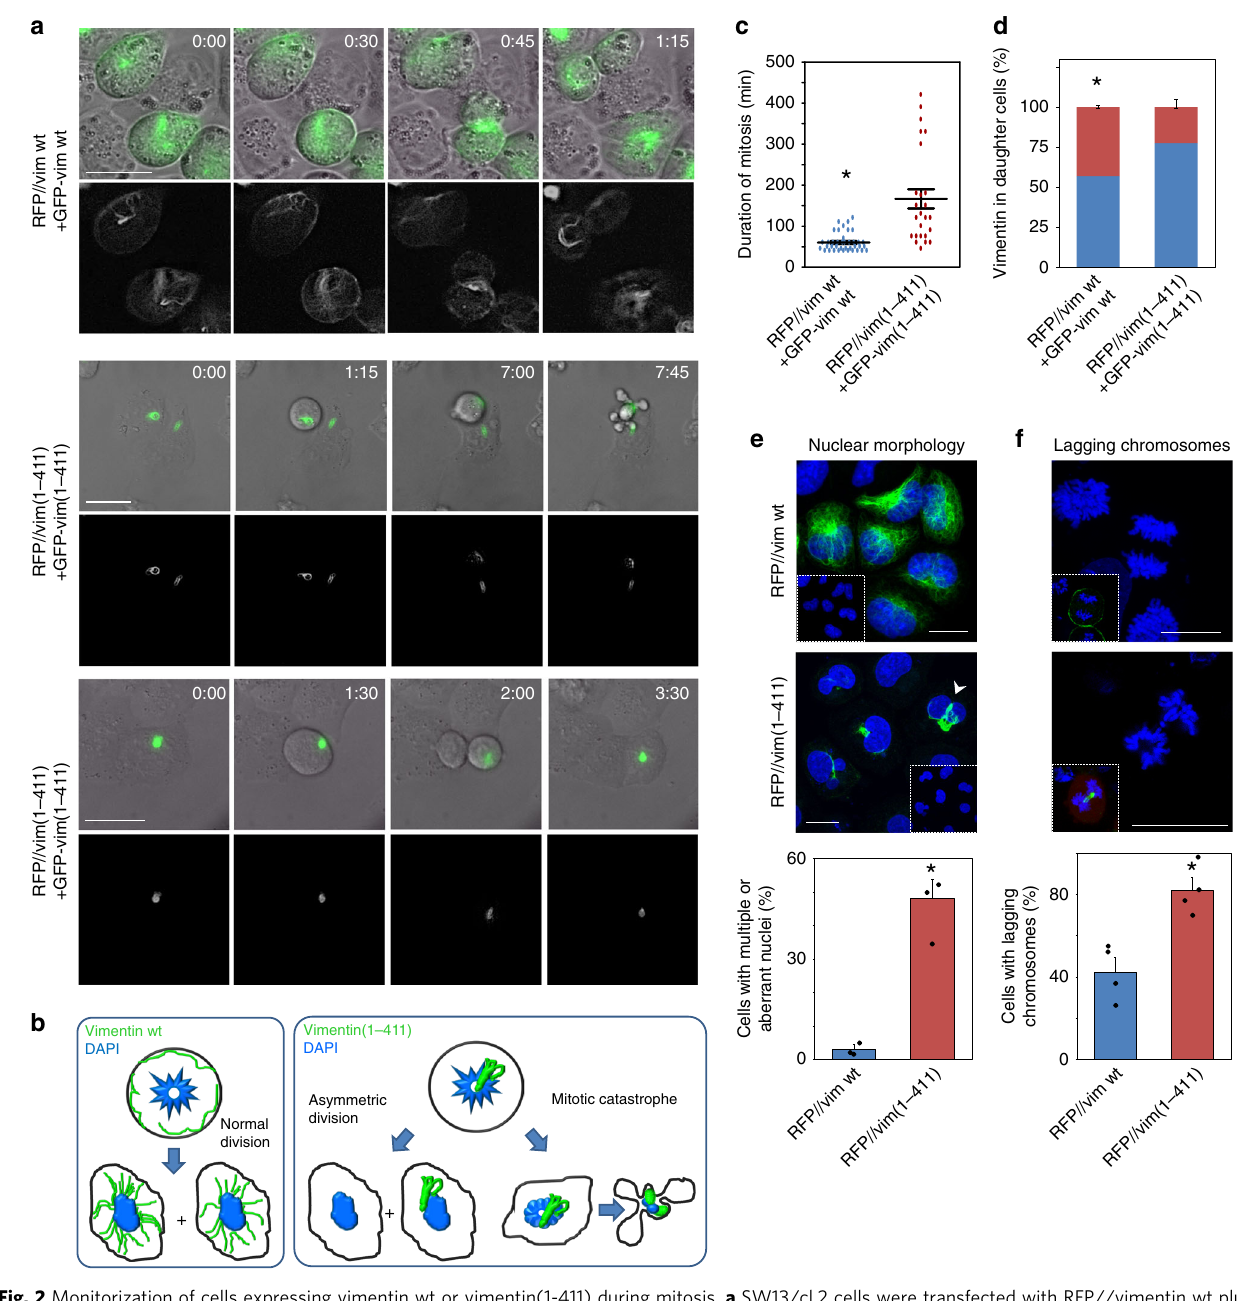
Fig. 2 Monitorization of cells expressing vimentin wt or vimentin(1-411) during mitosis. a SW13/cl.2 cells were transfected with RFP//vimentin wt plus a tracer amount of GFP-vimentin wt, or the equivalent constructs for vimentin(1-411), as indicated, for live cell monitoring by time-lapse microscopy. Several fi elds were randomly selected and images were acquired every 15 min. Representative images of the overlays of DIC and vimentin green fl uorescence (upper panels) and green fl uorescence only (lower panels, in gray scale), at the indicated time points, are shown. Scale bars, 20 μ m. b Schematic representation of the main fates observed for cells transfected with each construct. c Duration of mitosis from cell rounding to separation of daughter cells (* p < 10 − 6 ). d The proportion of vimentin signal present in each daughter cell is presented in different colors (* p < 10 − 5 ). e SW13/cl.2 cells were transfected with RFP//vim wt or (1-411). Nuclear morphology was assessed by DAPI staining and vimentin distribution by immuno fl uorescence. The percentage of cells showing multiple or aberrant nuclei (arrowheads) is depicted in the lower graph (* p < 0.002). f SW13/cl.2 cells, transfected as in e , were synchronized by mild nocodazole treatment. Cells in anaphase were monitored 100 min after nocodazole removal and the proportion of cells showing lagging chromosomes, assessed by DAPI staining, is depicted in the lower graph (* p < 0.01). The number of determinations for the experimental conditions shown in graphs from left to right was the following: c 38, 25; d 24, 16; e 3 totaling 336 cells, 3 totaling 219 cells; f 4 totaling 96 cells, 4 totaling 64 cells. Average values ± SEM are shown. All p values were obtained with two-tailed, unpaired Student ’ s t -test and original datasets are provided